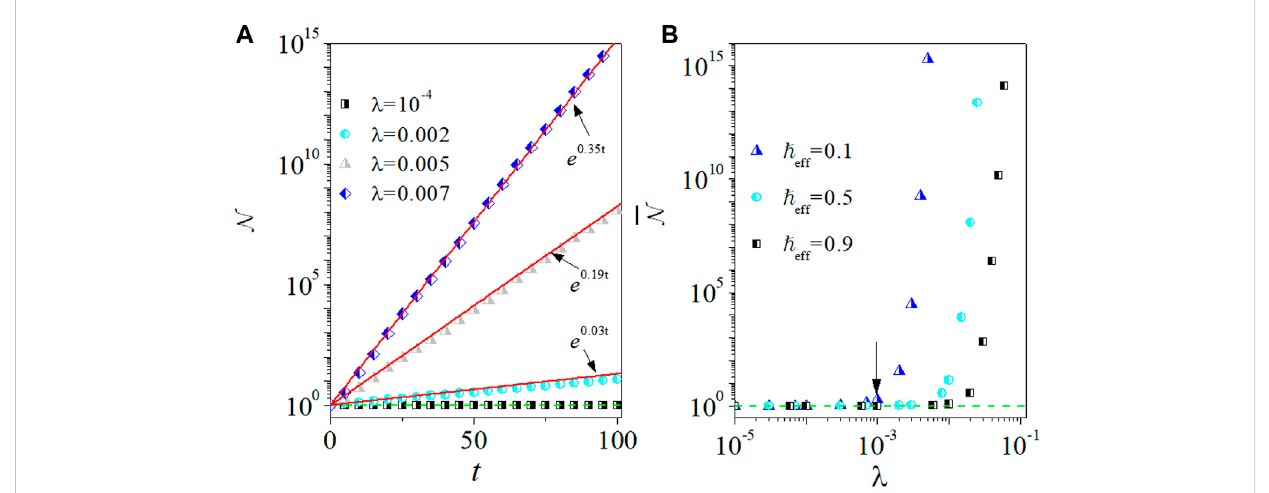
FIGURE 1 (A) Time dependence of N for Z eff = 0.1 with λ = 10 – 4 (squares), 0.002 (circles), 0.005 (triangles), and 0.007 (diamonds). Solid lines indicate the exponential fi tting N (cid:1) e γ t . (B) Theaveragevalue (cid:2) N versus λ with Z eff =0.1(squares),0.5(circle),and0.9(triangles).Arrowsmarkthephasetransitionpoint λ c for Z N (cid:1) 1 and (cid:2) N (cid:1) 1, respectively. The parameter is K = 2 π . eff = 0.1. Horizontal dashed lines in (A,B) denote